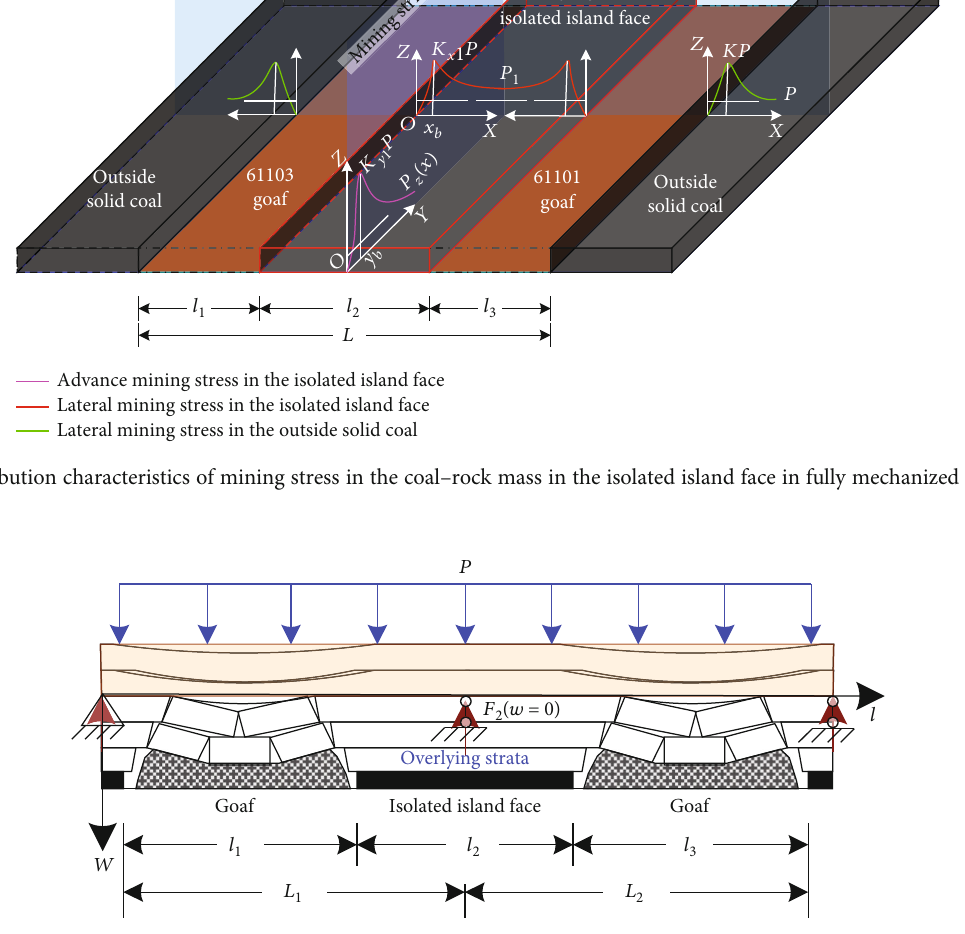
Figure 6: Continuous beam structure model of the overlying strata in the isolated island